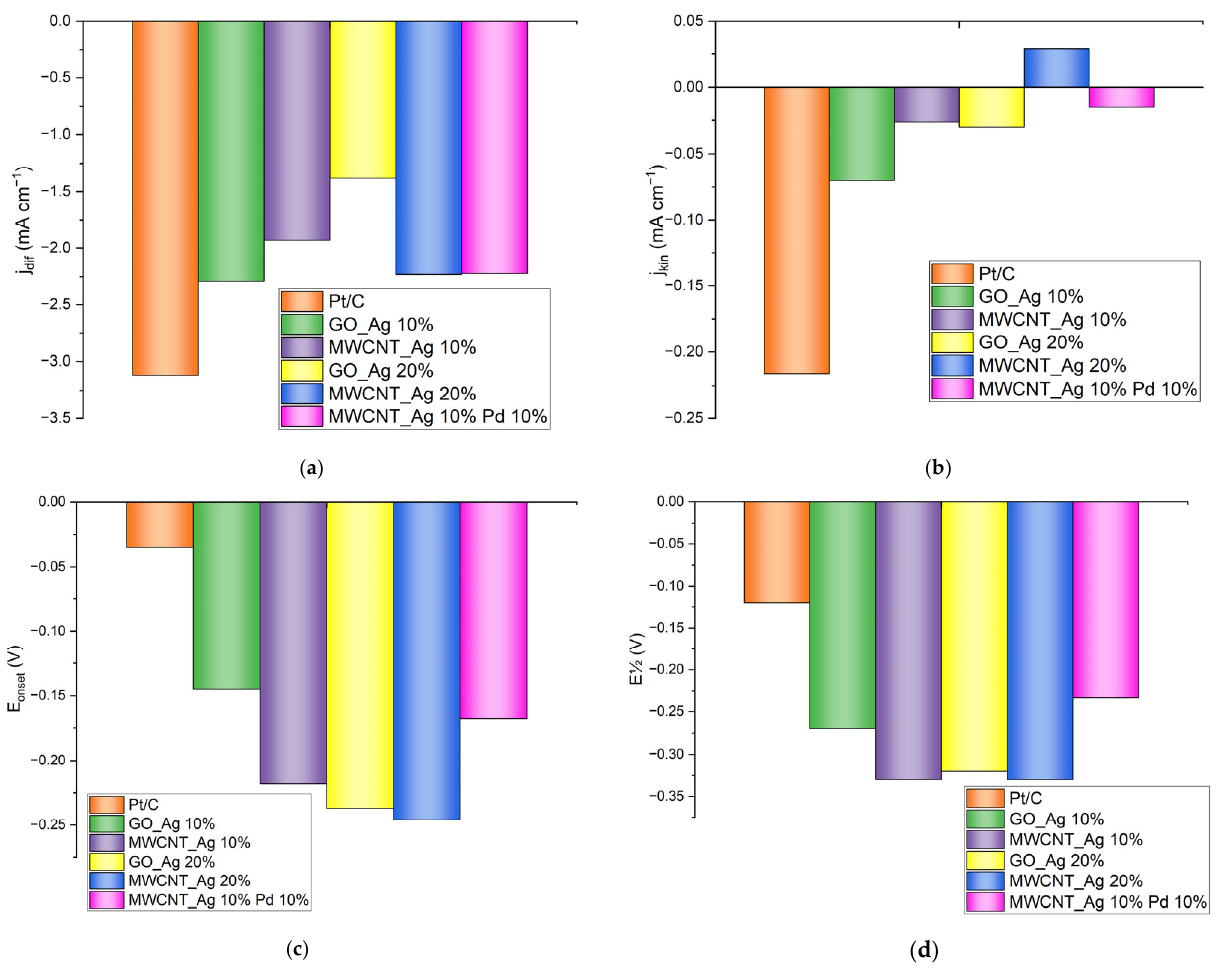
Figure 7. Comparative diagrams for synthesized catalysts and commercial platinum catalyst: ( a ) current densities in the diffusion region, ( b ) current densities in the kinetic region, ( c ) initial potential, ( d ) half ‐ wave potential.